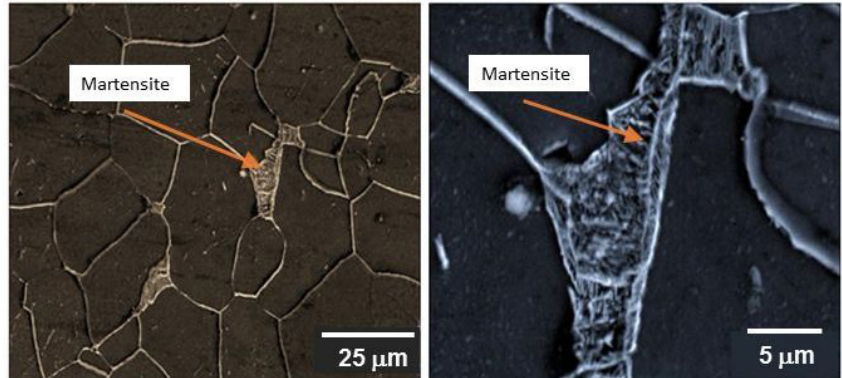
Figure 11. Microstructure of 1008 steel deformed at 800°C, 1000X and 4000X, strain rate of 10 -1 s -1 . Martensite in a ferritic matrix.